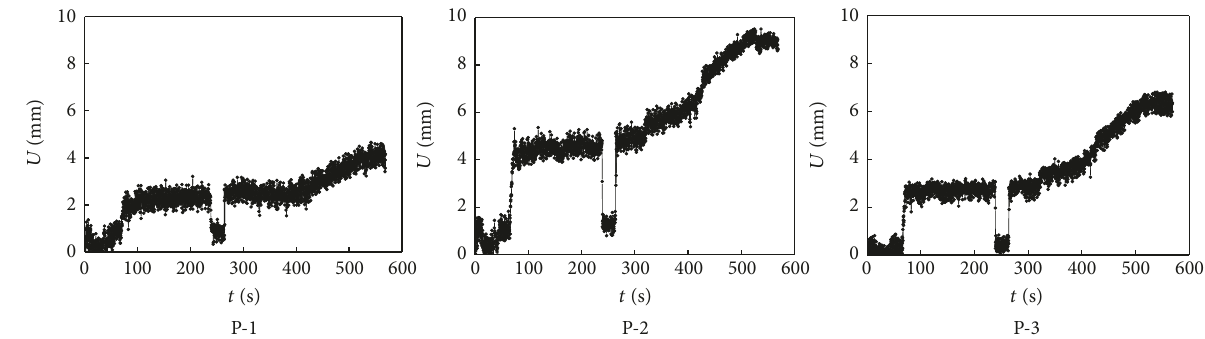
Figure 8: The deformation-time curves of the three measuring